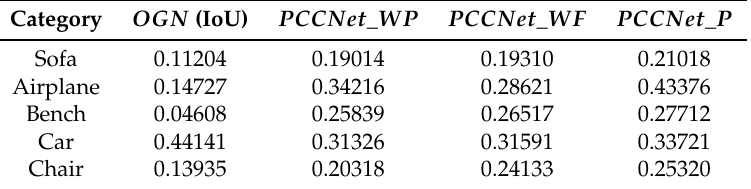
Table 2. IoU scores of OGN and PCCNet .